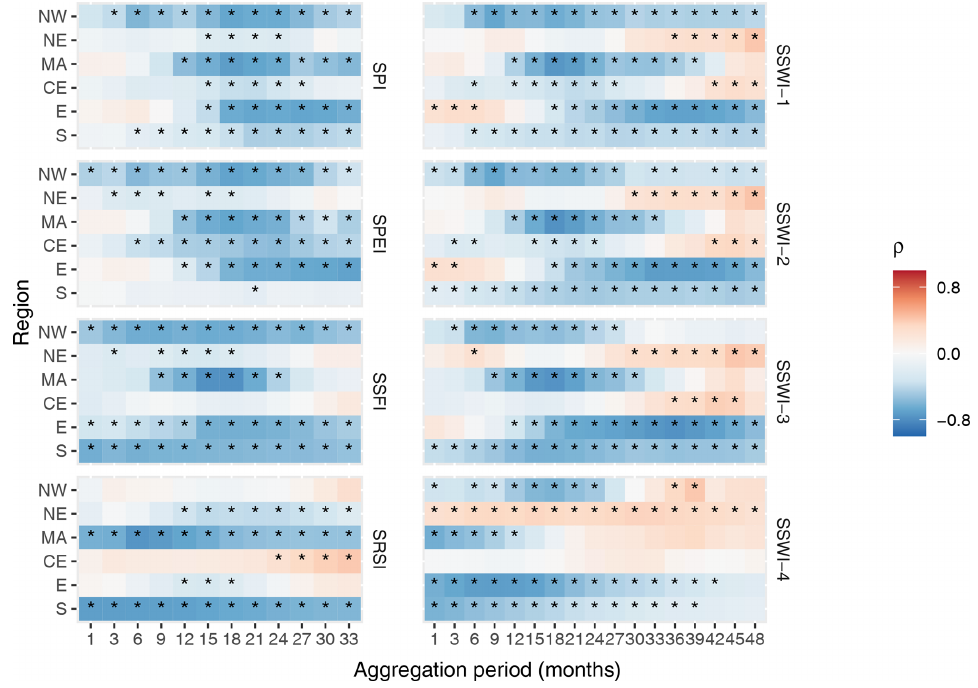
Figure 4. Correlation coefficients ( ρ ) between time series of drought indicators and impact occurrences for each sub-region, using one of the most censoring counting methods (CM1). Asterisks indicate the significance ( p < 0 .